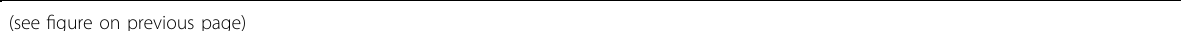
(see fi gure on previous page) Fig. 1 ARPE-19 cells treated with SI manifest necrotic phenotype. A Cell viabilities determined by CCK assays after NaIO 3 treatment for 12 h or 24 h at indicated concentrations ( n = 4). B ARPE-19 cells were cultured with NaIO 3 at indicated concentrations for 24 h. After the treatment, the LDH levels were determined by the LDH assays ( n = 4). C Left: Fluorescence images of cells stained with JC-1, an indicator of mitochondrial membrane potential (MMP). ARPE-19 cells were treated with 10 mM NaIO 3 for 24 h. Scale bar: 100 μ m. Right: The ratio of red/green fl uorescence intensity shows the change of MMP ( n = 3). D ARPE-19 cells treated with 10 mM NaIO 3 for 24 h were observed by scanning electron microscope. Scale bar: 20 μ m. E Upper: Fluorescence images of cells treated with 10 mM NaIO 3 for 24 h followed by Hoechst 33342 and PI double staining. Scale bar: 100 μ m. Lower: Cells positively stained with Hoechst and PI were counted using Image J software. Graphs represent the percentage of Hoechst and PI stained cells against total cells ( n = 3). F Fluorescence-activated cell sorting (FACS) histograms of Annexin V-FITC/PI stained cells with (right) and without (left) the treatment of 10 mM NaIO 3 for 24 h (Q1: cellular debris or necrotic cells; Q2: necrotic or late apoptotic cells; Q3: early apoptotic cells; Q4: viable cells). G Left: Effect of the caspase inhibitor Z-VAD on ARPE-19 cell death. Cells were pretreated with Z-VAD or solvent alone (DMSO) at indicated concentrations for 3 h and followed by co-treatment with or without 20 mM NaIO 3 for 24 h ( n = 4). Right: A positive control for apoptosis inhibition by Z-VAD. Jurkat cells were pretreated with 100 μ M Z-VAD or solvent alone (DMSO) for 3 h followed by co-treatment with 1.5 μ M doxorubicin (DOX)